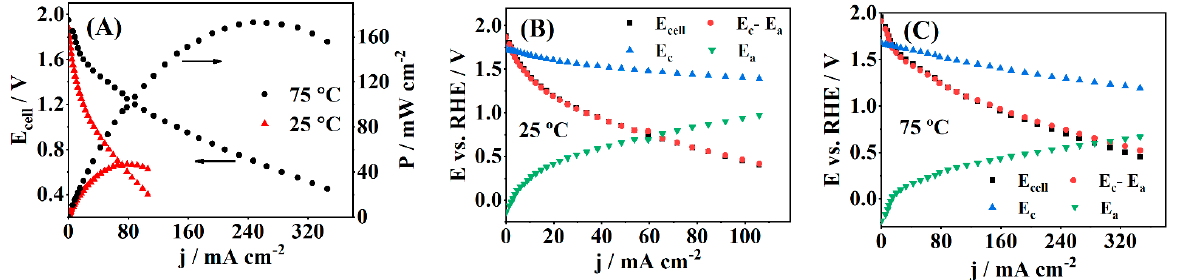
Figure 8. ( A ) Polarization and power density curves at 25 and 75 °C for a DBPFC using a PdAuNi/C SBIPA anode and a Pt cathode. The cathode and anode potentials, their potential difference, and E cell are also represented at ( B ) 25 °C and ( C ) 75 °C.